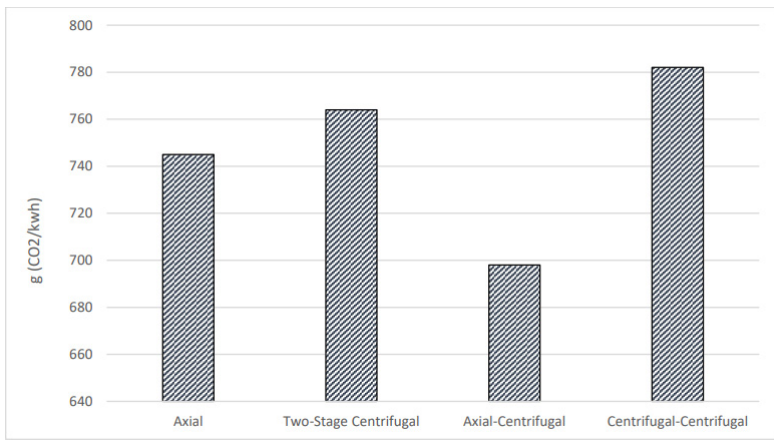
Figure 10. CO 2 emissions in g CO 2 /kWh for the four proposed systems.